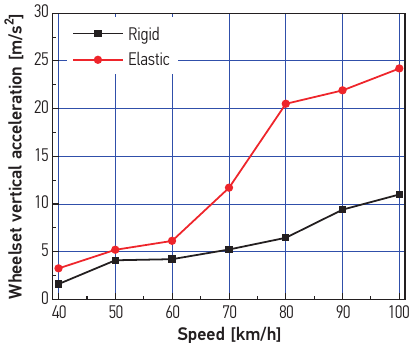
Fig. 6. The wheelset absolute maximum vertical vibration acceleration under different speeds